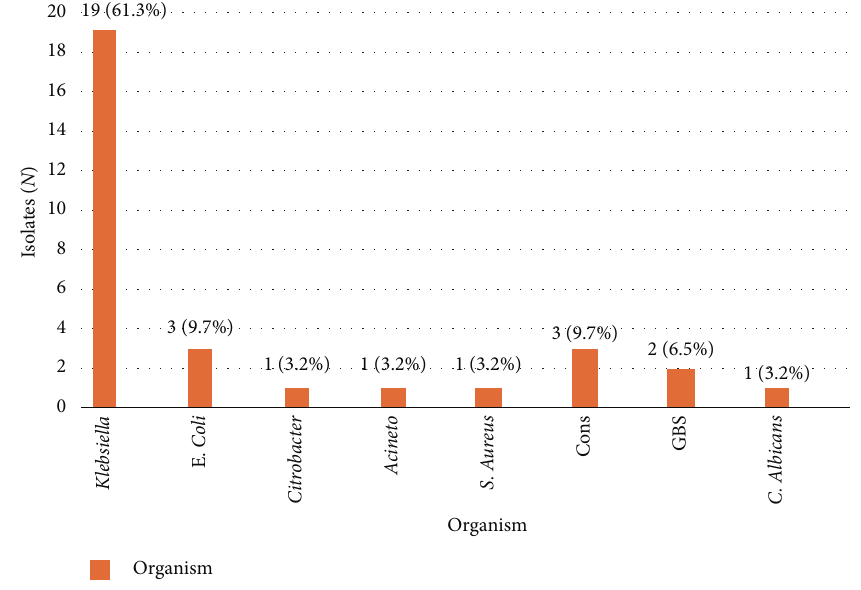
Figure 1: Isolated organisms in infants with neonatal sepsis. Table 3: Comparison of blood culture and PCR results of the studied neonates.